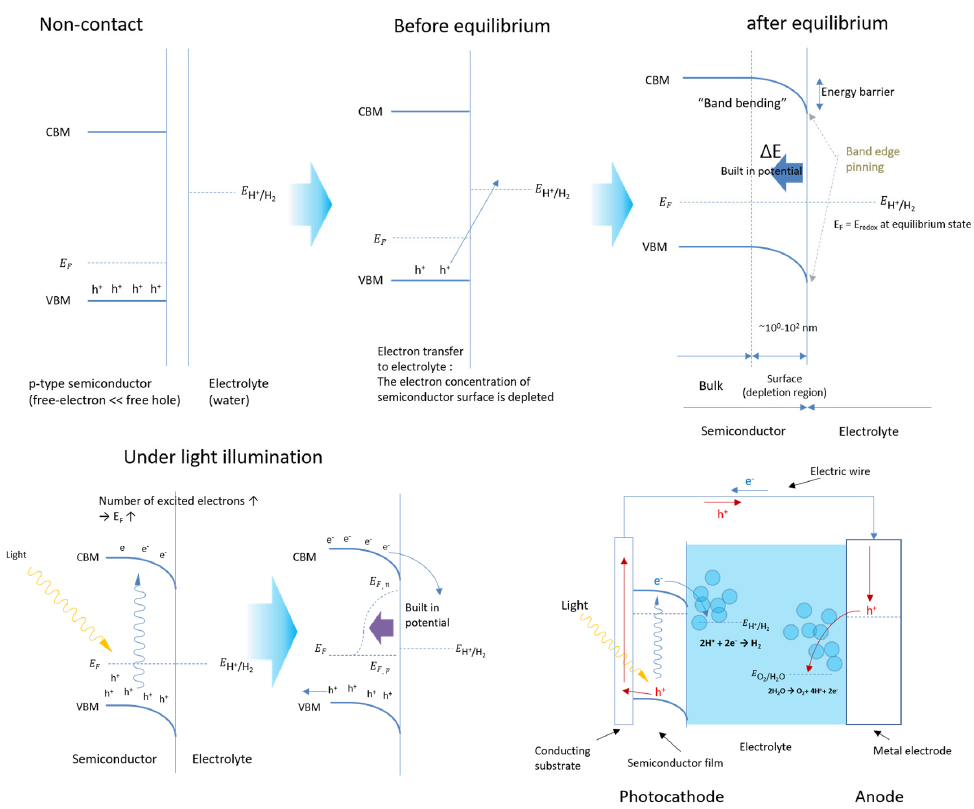
Figure 1. Band bending of p-type semiconductors in electrolytes. When the semiconductor and electrolyte are contacted, the Fermi level of the semiconductor and the chemical potential of the electrolyte become equilibrated and lead to a ‘band-bending energy’ structure. Under the light illumination condition, the excess photo-excited charge carrier breaks the equilibrium state and leads to charge separation via built-in potential at the semiconductor–electrolyte interface. A schematic of a photoelectrochemical (PEC) cell with a p-type semiconductor photocathode is also depicted for water splitting. Photo-excited electron is transported to the semiconductor/electrolyte interface, while the photo-excited hole is transported to the counter electrode through electrical wire and then to the counter electrode–electrolyte